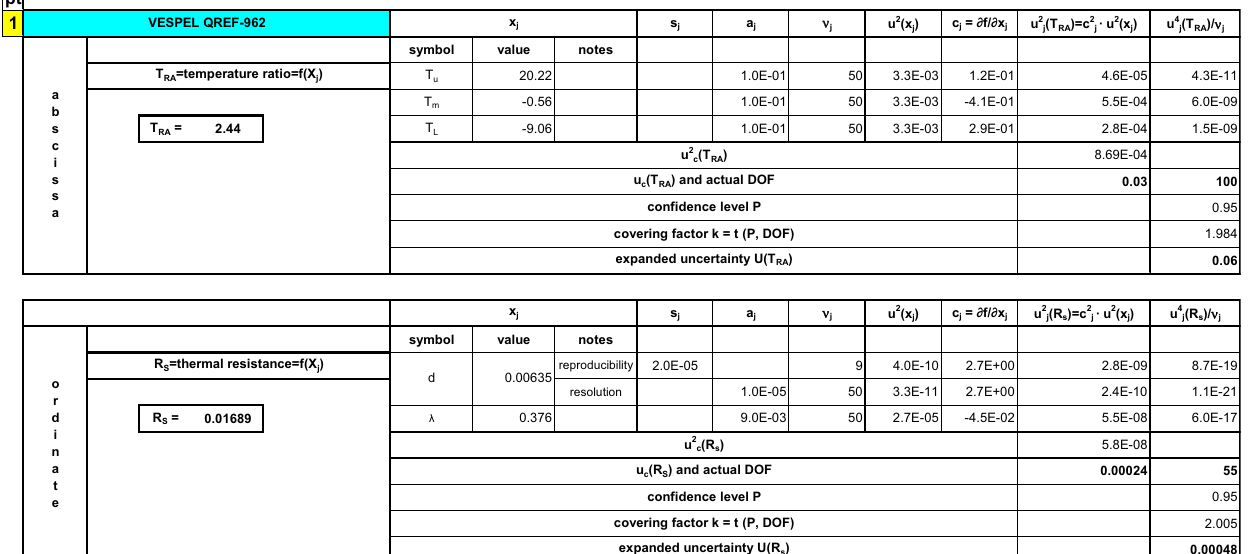
Table 1. Uncertainty budget for one of the six reference materials: VESPEL